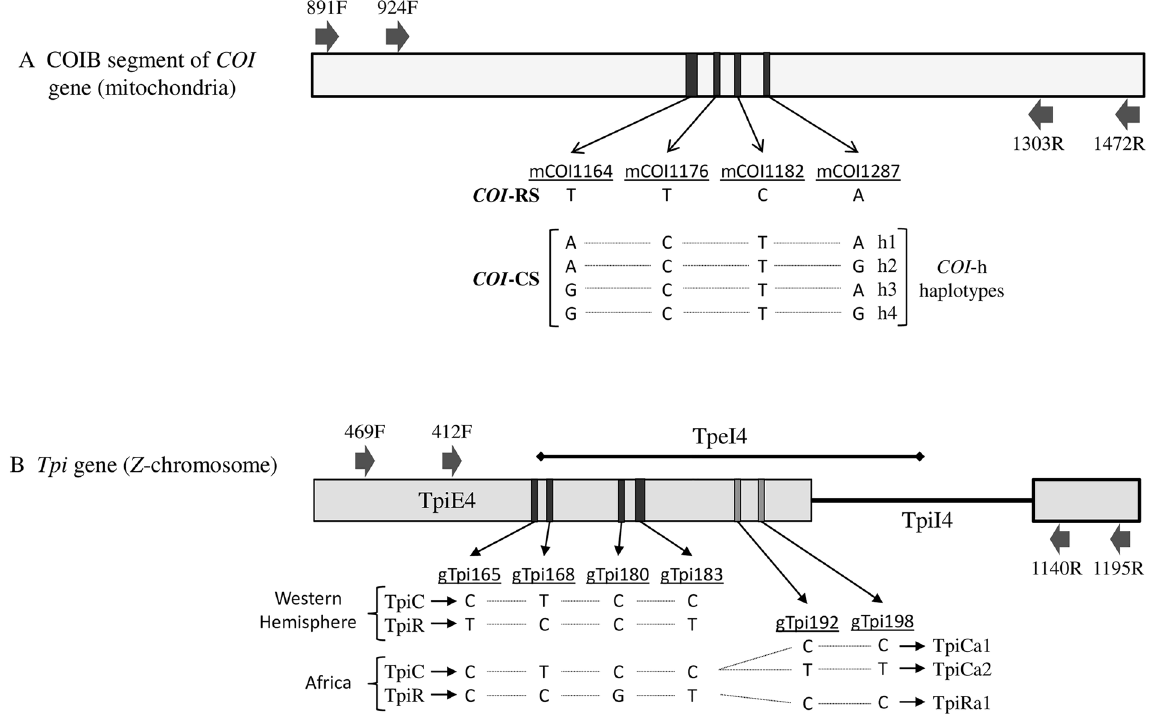
Figure 2. Diagrams of the relevant COI and Tpi gene segments, with descriptions of polymorphisms used to identify different haplotypes. Vertical lines in gene segments indicated site of single-base polymorphism with the thicker band indicating polymorphism diagnostic of strain identity. ( A ) COIB polymorphisms and the haplotypes observed in African FAW. Sites mCOI1164D and mCOI1287R identify strain and the h-haplotypes (h1-4). Sites mCOI1176 and mCOI1182 are also strain-specific in Western Hemisphere populations. ( B ) Diagram of the Tpi sequence used to PCR amplify the TpiE4 exon segment. Site gTpi183 is diagnostic of Tpi-based strain identity in all locations. Sites gTpi165 and gTpi168 are also strain-specific in the Western Hemisphere. Sites gTpi168 and gTpi180 are also strain-specific in Africa. Sites gTpi192 and gTpi198 are polymorphic but not strain-specific in all locations. Block arrows indicate location of primers used for PCR amplification and DNA sequencing.